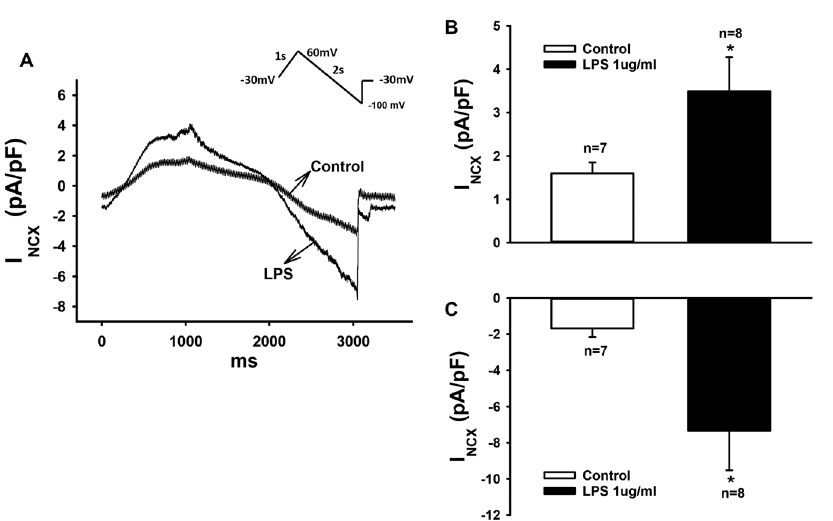
Figure 8. LPS-treatment enhanced Na/Ca exchanger currents (I NCX ). I NCX was evoked by ramp pulses (100 mV/s) at 0.5 Hz from − 30 to + 60, then to − 100 mV with the holding potential of − 30 mV. NiCl 2 (5 mM) was used to isolate I NCX from other currents. ( A ) Representative traces of Ni 2 + -sensitive currents in absence and presence of LPS (1 µ g/ml for 48 hours). ( B , C ) Mean values of peak I NCX at + 60 and − 100 mV. Values given are mean ± SEM. n, number of cells. * p <